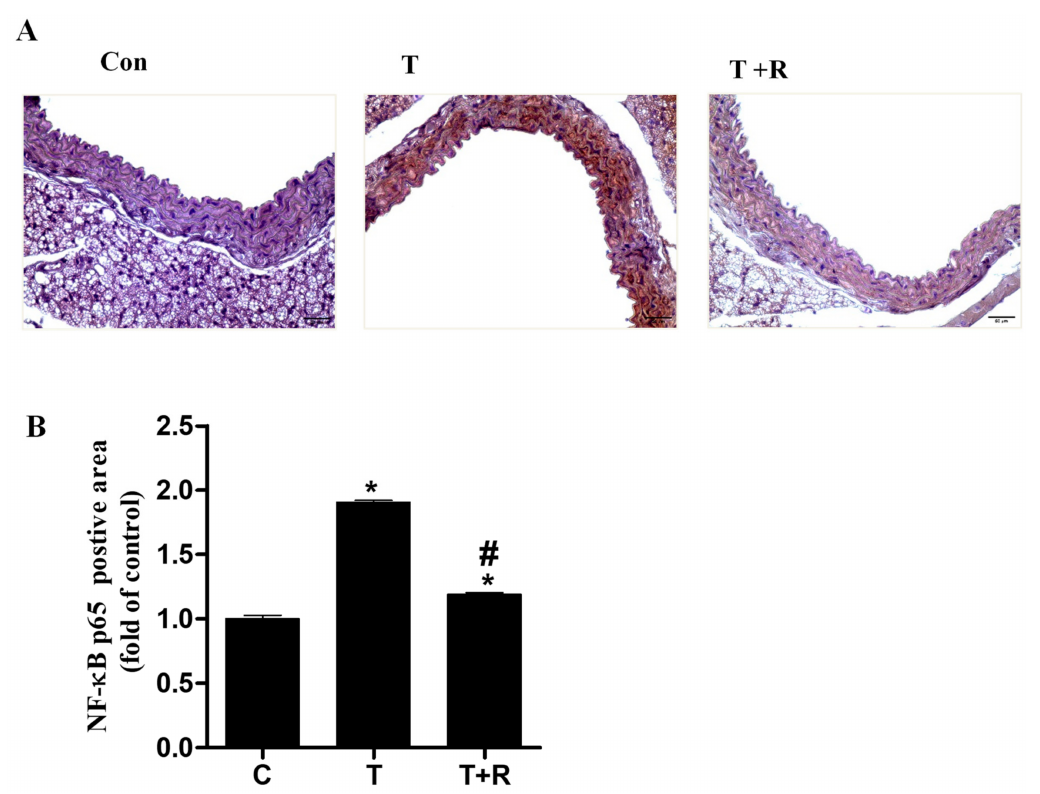
Figure 7. Representative images showing the immunohistochemical staining for NF- κ B p65 in aortic cross-sections (magnification of 40 × , scale bar = 50 µ m). C57BL/6 mice were fed AIN-93G rodent diets with and without 0.4% resveratrol for one week followed by 25 µ g/kg/day of TNF- α injected intraperitoneally for 7 days. After treatment periods, the animals’ aortas were harvested for sectioning. Representative photomicrographs of immunohistochemical staining for NF- κ B p65 ( A ). Quantitative analysis of NF- κ B p65 ( B ). T, TNF- α ; T+R, TNF- α + resveratrol. *, p < 0.05 vs. control; #, p < 0.05 vs. TNF- α -alone-treated